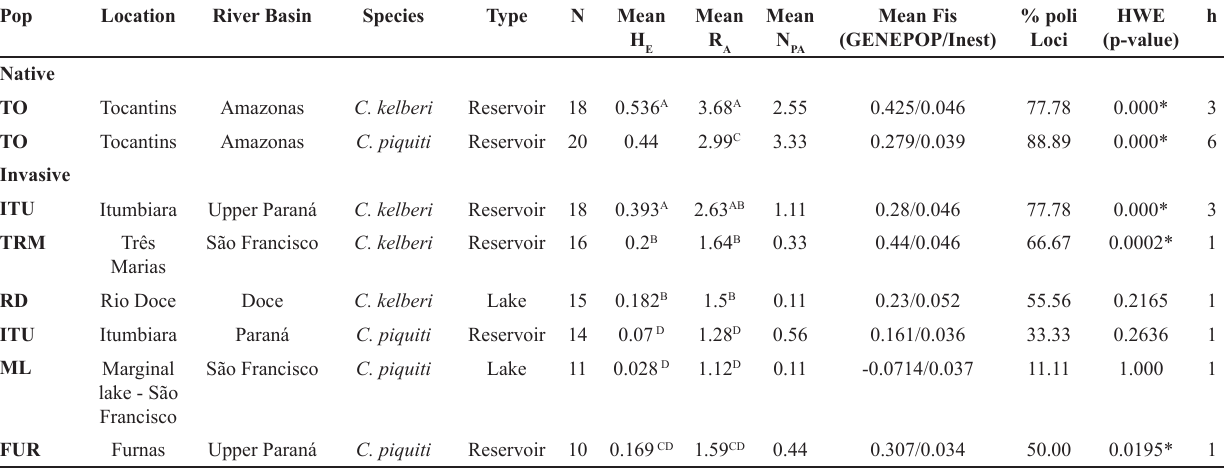
Table 1. Measures of genetic diversity for the two species of Cichla . Number of samples (N), mean allele richness (R Nei’s genetic diversity (H ), mean number of private alleles per population (N E of polymorphic loci (% poli Loci ), probability (p-value) of rejecting the HWE equilibrium for each population and number of Control region mtDNA haplotypes ( h ), data from Carvalho et al. (2009). Statistical significance differences between populations of H and R are presented. Identical letters within species indicate similar statistical values, whereas, distinct letters E A